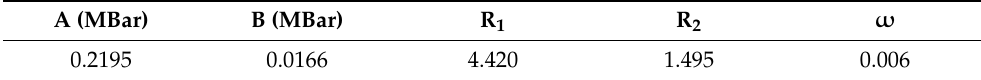
Figure 2. γ state equation curve and JWL curve of PTFE/Al products. Table 4. JWL equation of state parameters for PTFE/Al reaction